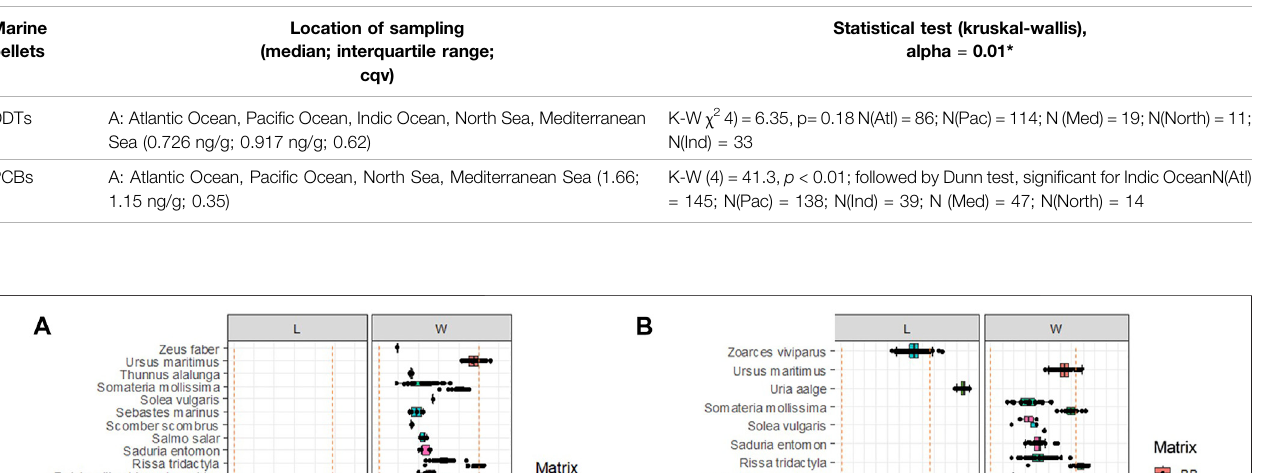
TABLE 3 | Concentration of DDTs and PCBs in marine pellets, P DDT and P PCB (Log). Marine pellets